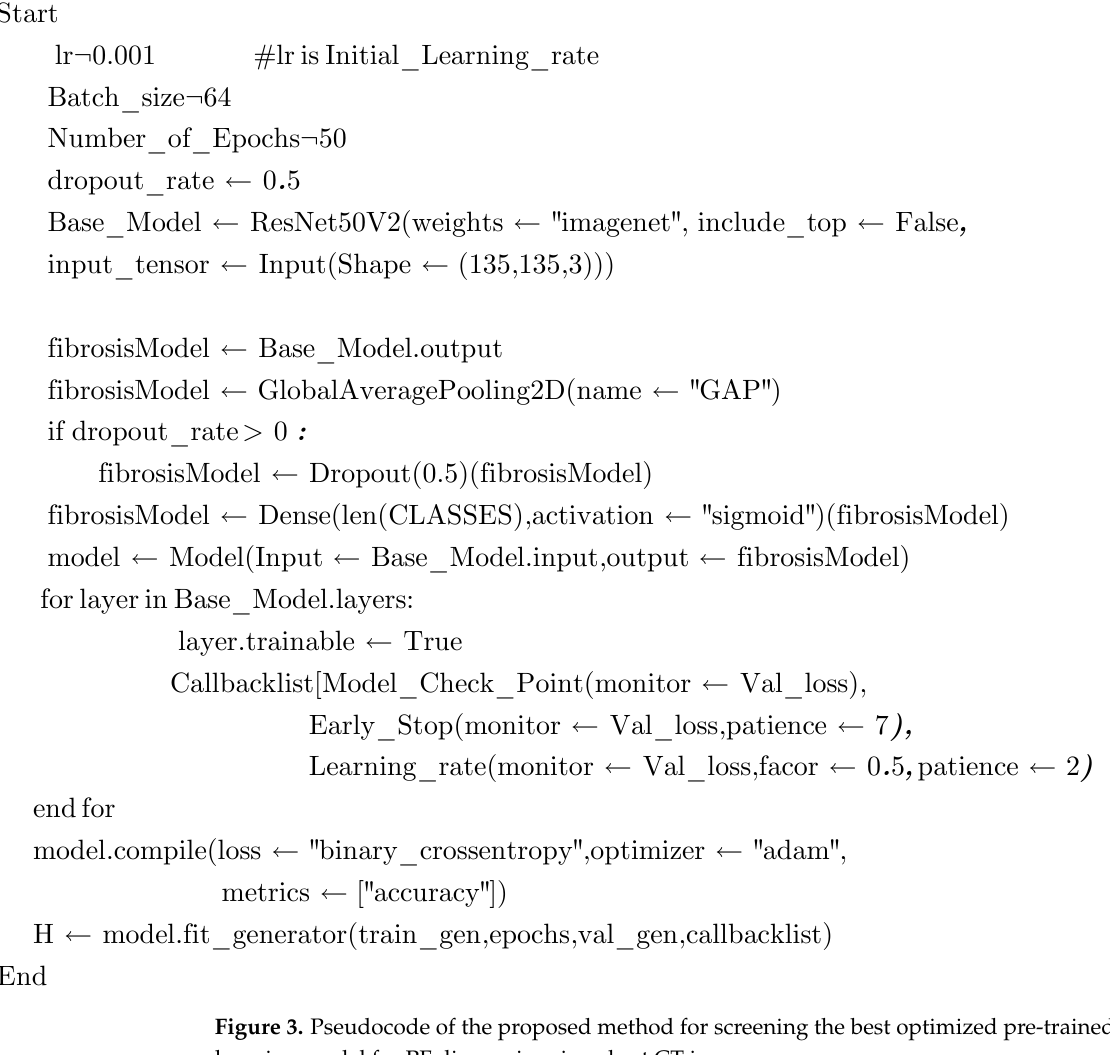
Figure 3. Pseudocode of the proposed method for screening the best optimized pre-trained transfer learning model for PF diagnosis using chest CT images.